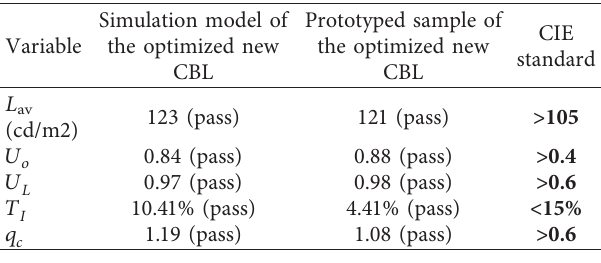
Table 2: Comparison of lighting performance between the opti- mized new CBL design and prototype sample measurements in threshold zone of a tunnel.